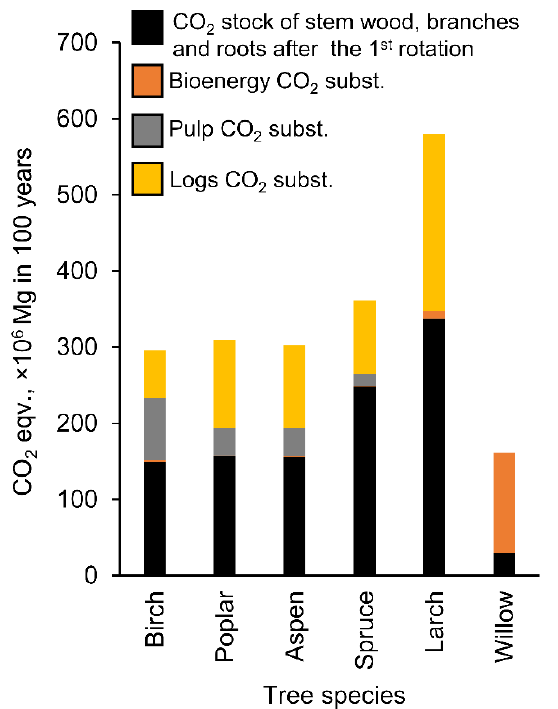
Figure 5. The total climate benefit at the landscape level according to the analyzed scenario expressed as the sum of removed CO 2 from the atmosphere due to increased carbon stocks and avoided CO 2 -emissions related to substitution effects over 100 years for the studied tree species.